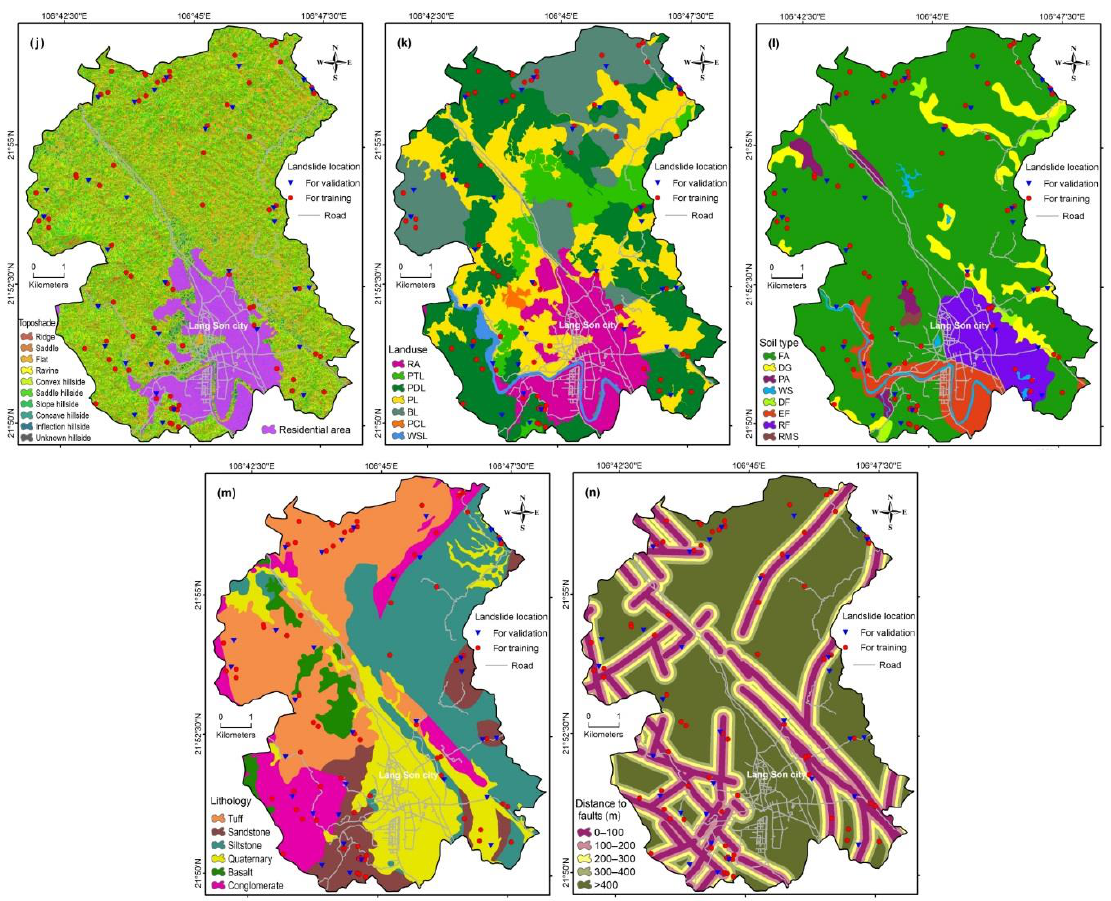
Figure 3. Landslide conditioning factors used in the study area: ( a ) Slope; ( b ) Slope length; ( c ) Aspect;